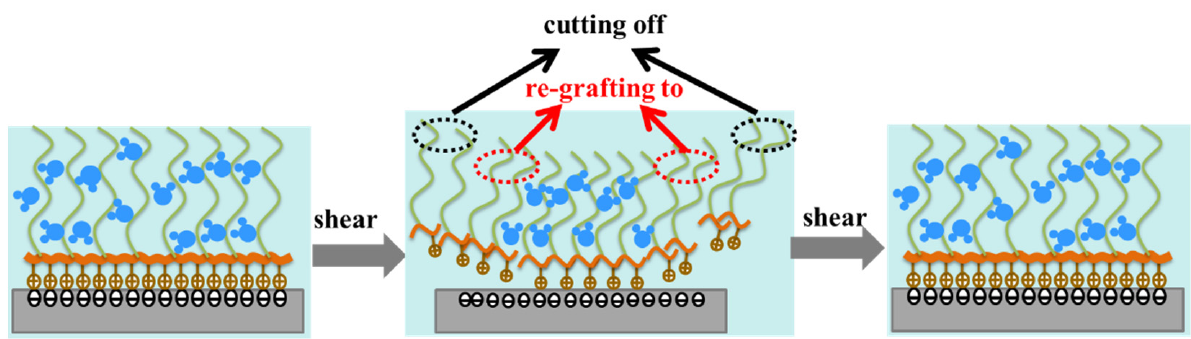
Figure 6. Schematic diagram of “self-healing” of PLL-g-PEG: the polymer was grafted to the surface (“grafting to”), sheared under shearing force (“cutting off”), then grafted to the surface (“re-grafting to”).